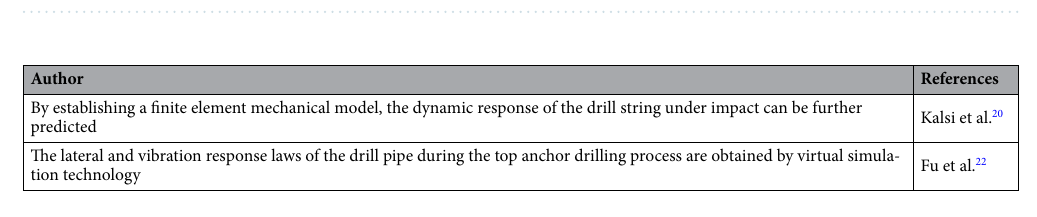
Table 2. Vibration characteristics analysis of drill string drilling